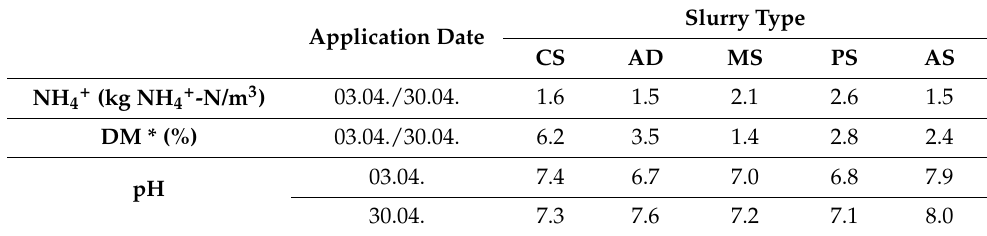
Table 3. Slurry composition for the acidification treatment experiment, 2014 (winter wheat